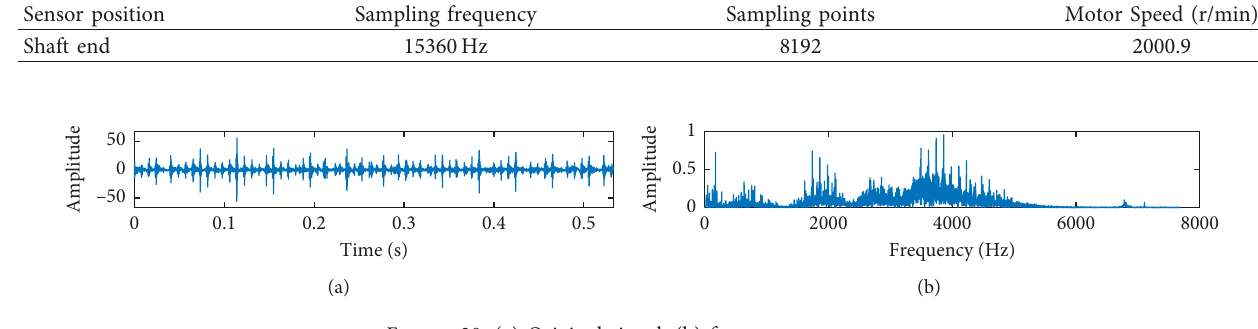
Figure 20: (a) Original signal; (b) frequency spectrum.